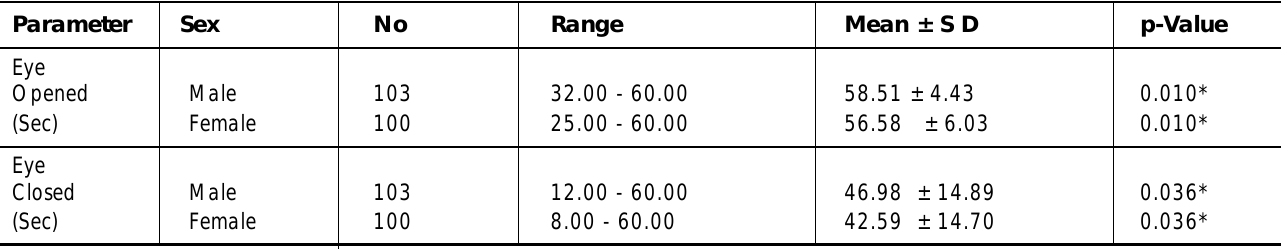
Table 2: Comparison between the performance of male and female (Independent t-test) in FRT and